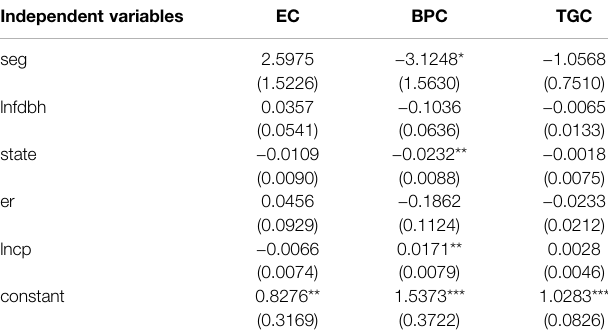
TABLE 9 | The in fl uencing path of market segmentation on thermal power ef fi